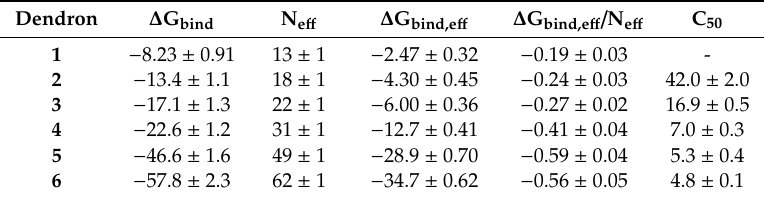
Table 2. The free energy of micellization ( ∆ G bind , kcal / mol), number of e ff ective charges (N e ff ), e ff ective free energy of binding ( ∆ G bind , e ff , kcal / mol), and e ff ective-charge-normalized free energy of binding ( ∆ G bind , e ff / N e ff ) between siRNA and dendrons 1 – 6 as derived from molecular simulations. The last column reports the siRNA / dendron binding data (C 50 , µ M) obtained from ethidium bromide (EB) displacement assays. Adapted from [7] with the permission of John Wiley and Sons,